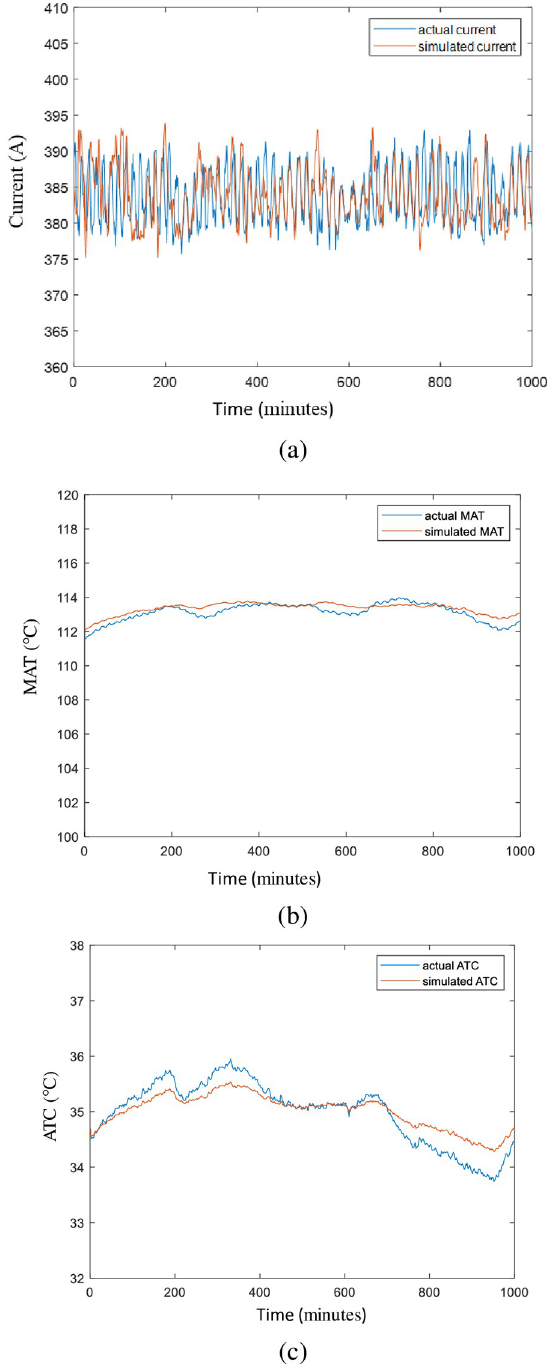
Fig 14. Combined HVIM model results for (a) electrical, (b) thermal and (c)